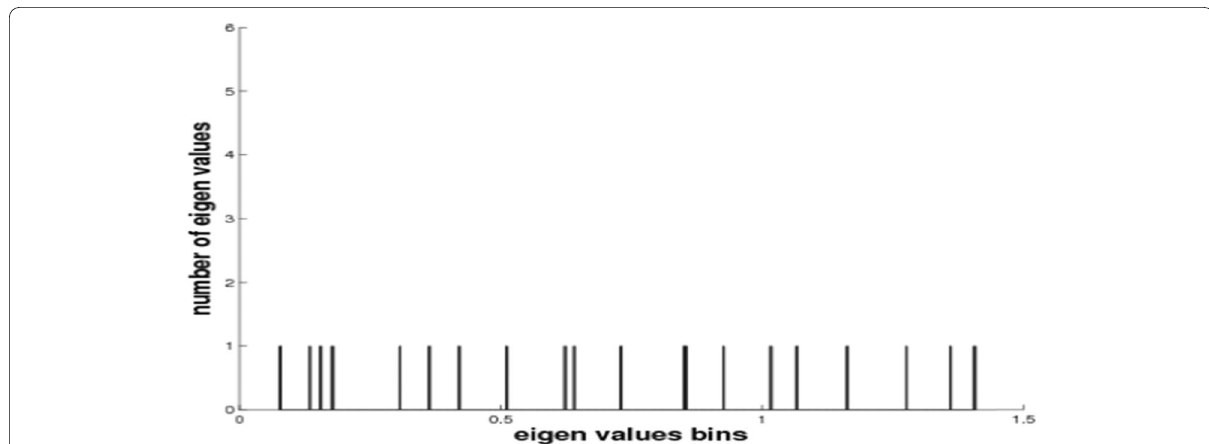
Fig. 11 Molecular dynamics of the docked complex. Eigenvalues